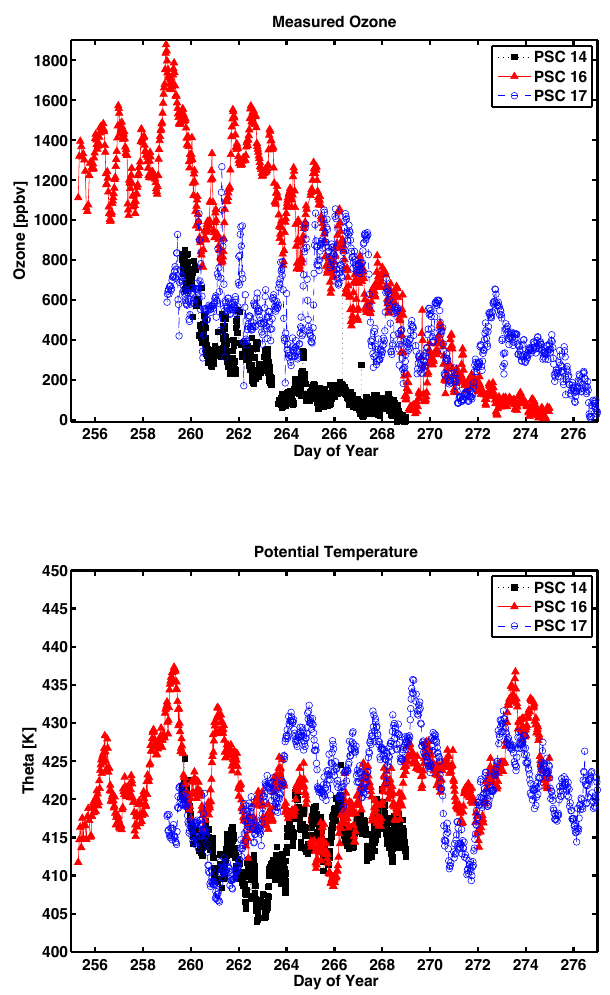
Figure 2. Ozone and potential temperature along the trajectory of each of the ozone instrumented Concordiasi balloons. Clearly mea- sured is the ozone loss under perturbed springtime conditions. The diurnal heating and cooling of the balloon is evident in the potential temperature